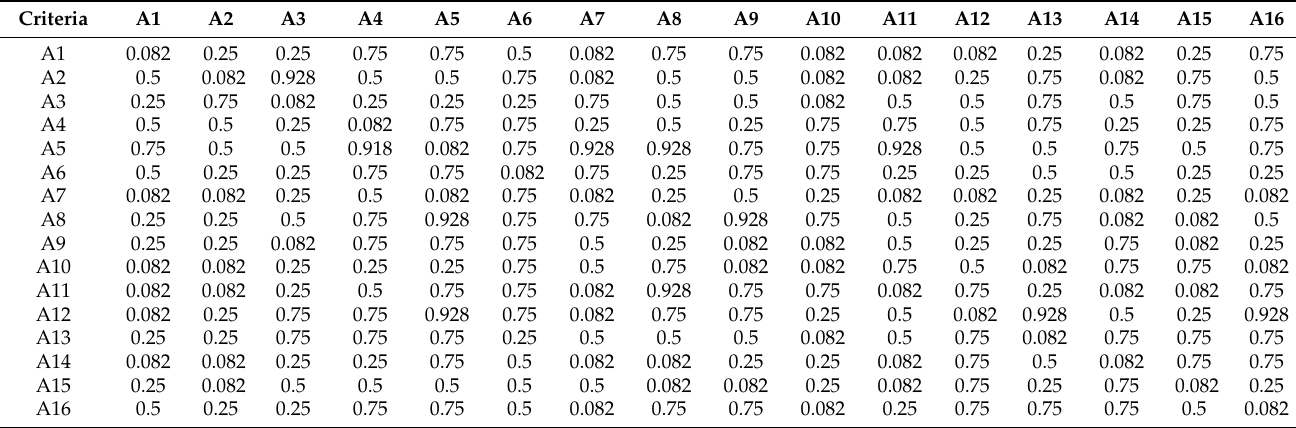
Table 4. Initial relation matrix F—the TBL’s